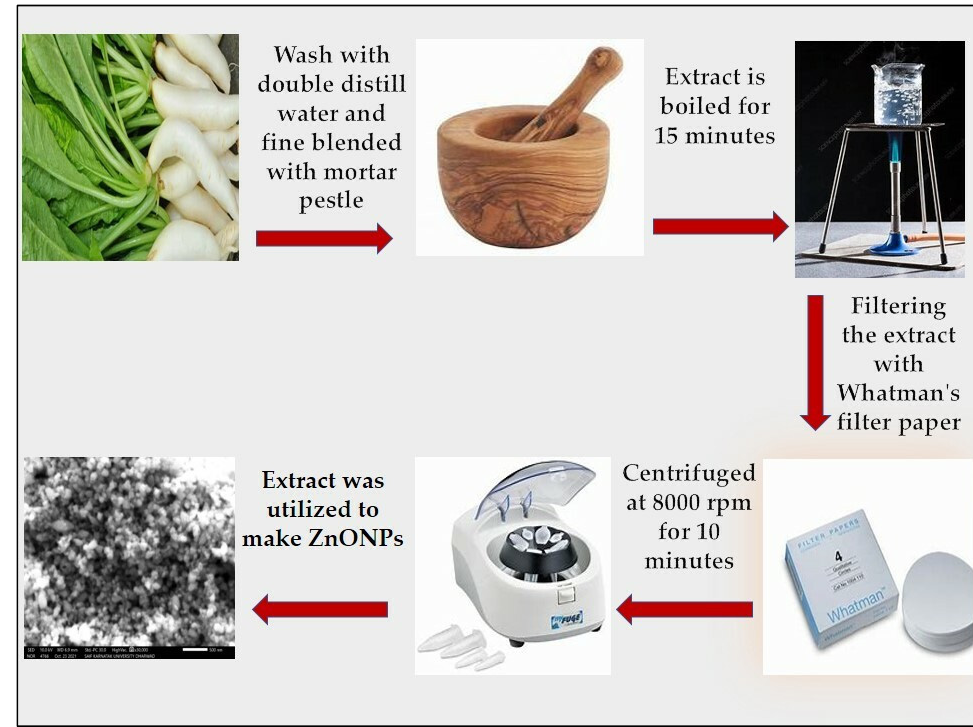
Figure 1. Preparation of R. sativus leaf extract ZnONPs.